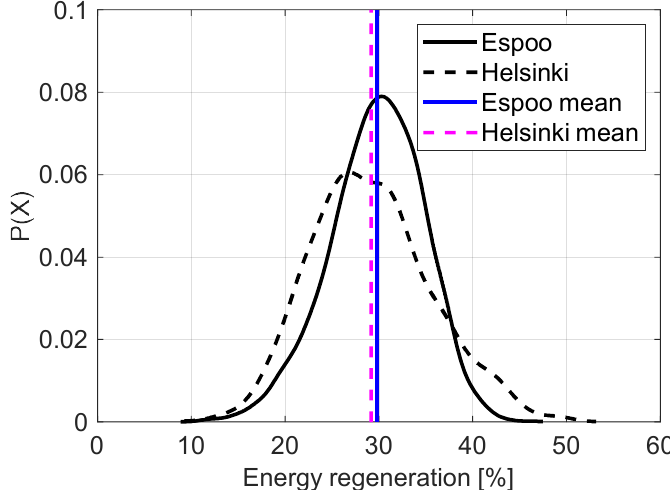
Figure 14. The probability density functions of energy regeneration in the suburban (Espoo) and city (Helsinki) routes.